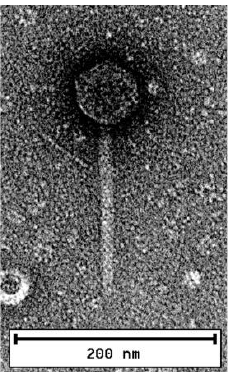
Figure 1. Visualization of the VarioGold virion.